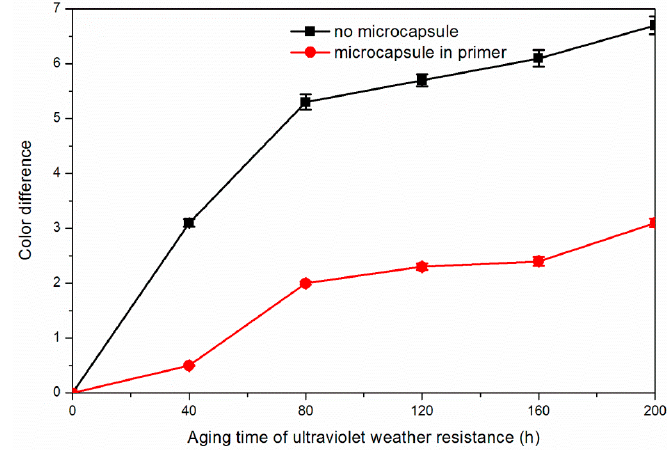
Figure 8. E ff ect of aging time on color di ff erence in the paint film in the ultraviolet weather resistance test. Figure 8. Effect of aging time on color difference in the paint film in the ultraviolet weather resistance test.